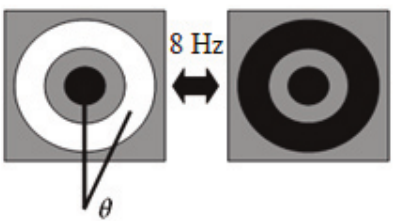
Fig. 1. A stimulus in the direct compensation method. The stimulus consists of a flickering annulus. The left image shows the on-phase (white annulus), and the right image shows the off- phase. The test field is in the centre of the ring (the dark circle). θ denotes the angular distance of the glare source from the fixation point.